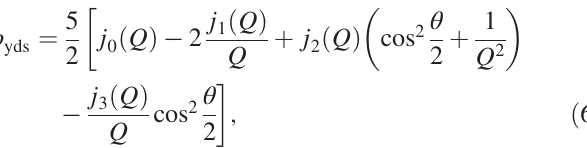
FIG. 4. The dependence of the YDS factor ρ the scattering angle θ ¼ ∠ ð k 0 ; k Þ for S K β RIXS of CS 2 with e 0 ⊥ e . The DSB mechanism is responsible for the breakdown of selection rules at the small-angle scattering (shaded area), where ρ ≈ 1 . This is in contrast to large-angle scattering, where yds ρ ≪ 1 and the reason for the selection-rules violation is the yds orientational dephasing of YDS interference. Our experiment was performed at θ ¼ π = 2 , where ρ and the YDS interference is absent, which leads to violation of the selection